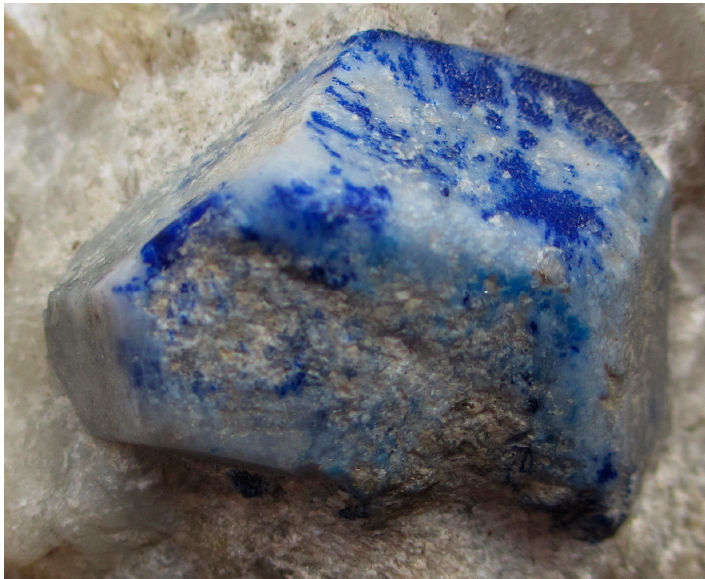
Figure 17. Epitaxy of S 3 • – -rich and SO 42– -depleted lazurite on a haüyne crystal from a metasomatic rock composed of calcite, forsterite, diopside, and pyrite. Sar-e Sang gem lazurite deposit, Afghanistan. Field of view width: 3 cm. Photographer: Nikita V. Chukanov.